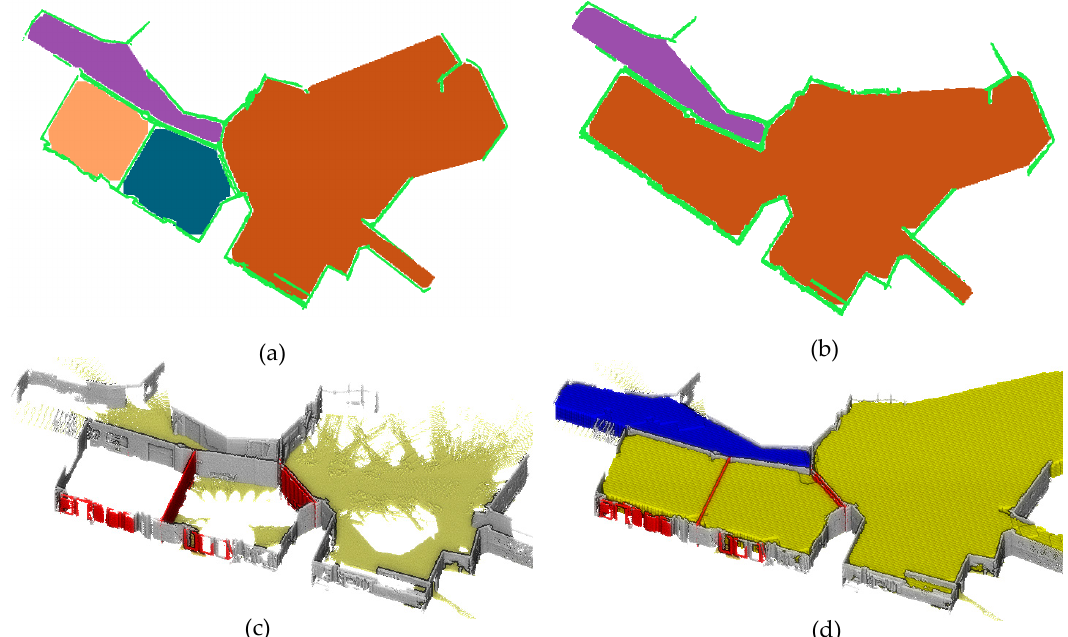
Figure 15. The top view of the spaces and permanent changes. ( a ) Epoch one, walls are in green and four spaces in random colors. ( b ) After removing walls, two rooms in epoch one are merged with the large space in brown color, and, in total, it forms two spaces with the rest of the interiors. ( c ) Detected permanent changes are shown in red. ( d ) The spaces from the second epoch are intersected with the permeant changes to identify the changes in the space.